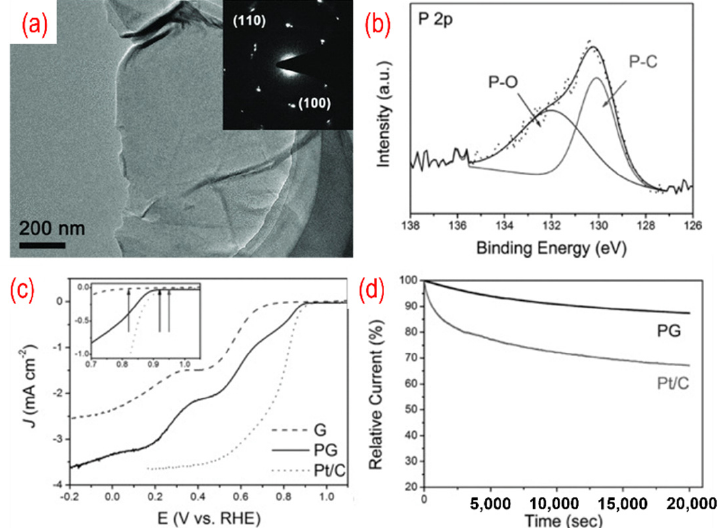
Figure 4. ( a ) The TEM image (the inset is the corresponding SAED pattern), ( b ) the high-resolution P 2p peaks, ( c ) the activity test (LSV curves recorded by RDE in O 2 -saturated 0.1 M KOH solution with 1600 rpm at a scanning rate of 10 mV s − 1 ), ( d ) the stability test (current-time chronoamperometric in O 2 -saturated 0.1 M KOH solution) of P-graphene. Reproduced with permission from [54]. Copyright © 2022 WILEY-VCH Verlag GmbH & Co. KGaA, Weinheim.